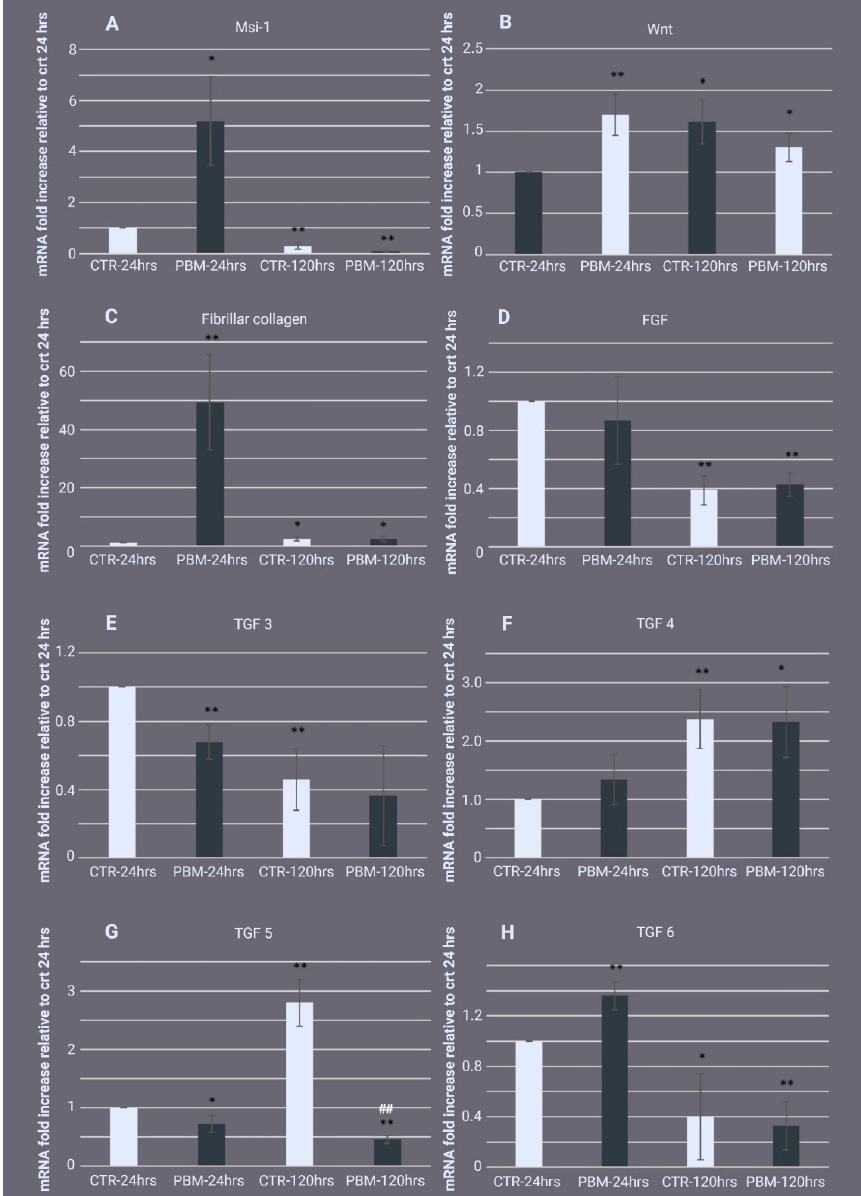
Figure 5. Effect of photo-biomodulation (PBM) on the expression of proliferation/differentiation, extracellular matrix synthesis, and growth factor genes. The real-time PCR gene expression quantification of ( A ) the pluripotent stem cell-inducer gene Musashi 1 (Msi-1); ( B ) the endogenous wingless protein (Wnt) signalling pathway; ( C ) fibrillar collagen; ( D ) fibroblast growth factor (FGF), and ( E ) transforming growth factor 3 (TGF3), ( F ) TGF4, ( G ) TGF5, and ( H ) TGF6 ( H ) in regenerating Chondrosia reniformis tissue 24 h (PBM-24 h) and 120 h (PBM-120 h) after PBM. The control groups (CTR-24 h and CTR-120 h) are the respective 810 nm-0 W PBM nonirradiated samples (0 J). The data are expressed as the messenger RNA (mRNA)-fold increase relative to CTR-24 h and are normalised to GAPDH expression. Each bar represents the mean ± standard deviation of three independent experiments performed in triplicate. The data were analysed with one-way analysis of variance (ANOVA) followed by Tukey’s test (ANOVA p -values: A , p = 0.013071; B , p = 0.001023; C , p = 0.000511; D , p = 0.003392; E , p = 0.000192; F , p = 0.000014). The asterisks indicate significant differences between the groups based on Tukey’s test versus CTR-24hrs, * p < 0.05, ** p < 0.01. The hash symbol indicates significant differences between groups based on Tukey’s test versus CTR-120 h, ## p < 0.01.